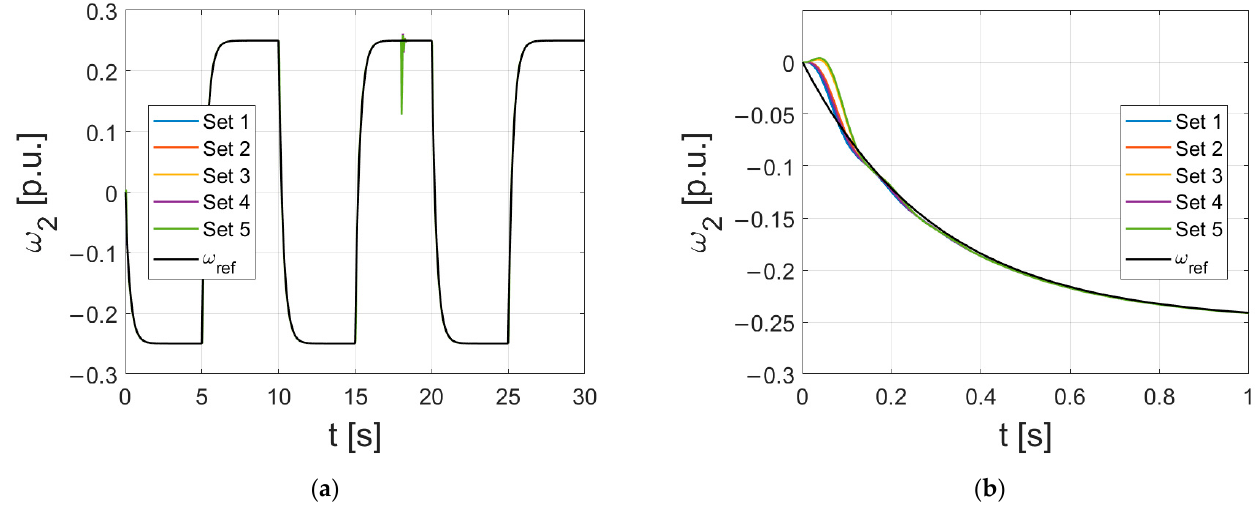
Figure 8. The impact of the change of the initial parameters of the RBF neural network: ( a ) the overview of the simulation run; ( b ) a zoom-in presenting the initial stage of the simulation.